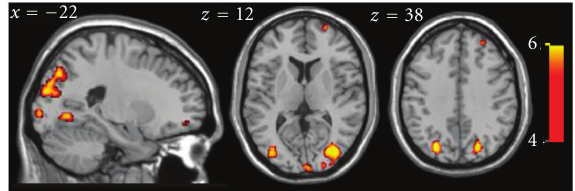
Figure 4: Cortical maps showing brain areas where activity was significantly larger in congenitally blind compared to blindfolded control subjects. The color-coded t-map shows the voxels with a relative increase in task-related activation in the blind group relative to controls at P < 0 . 01, FDR-corrected. Right side of the brain is to the right of the